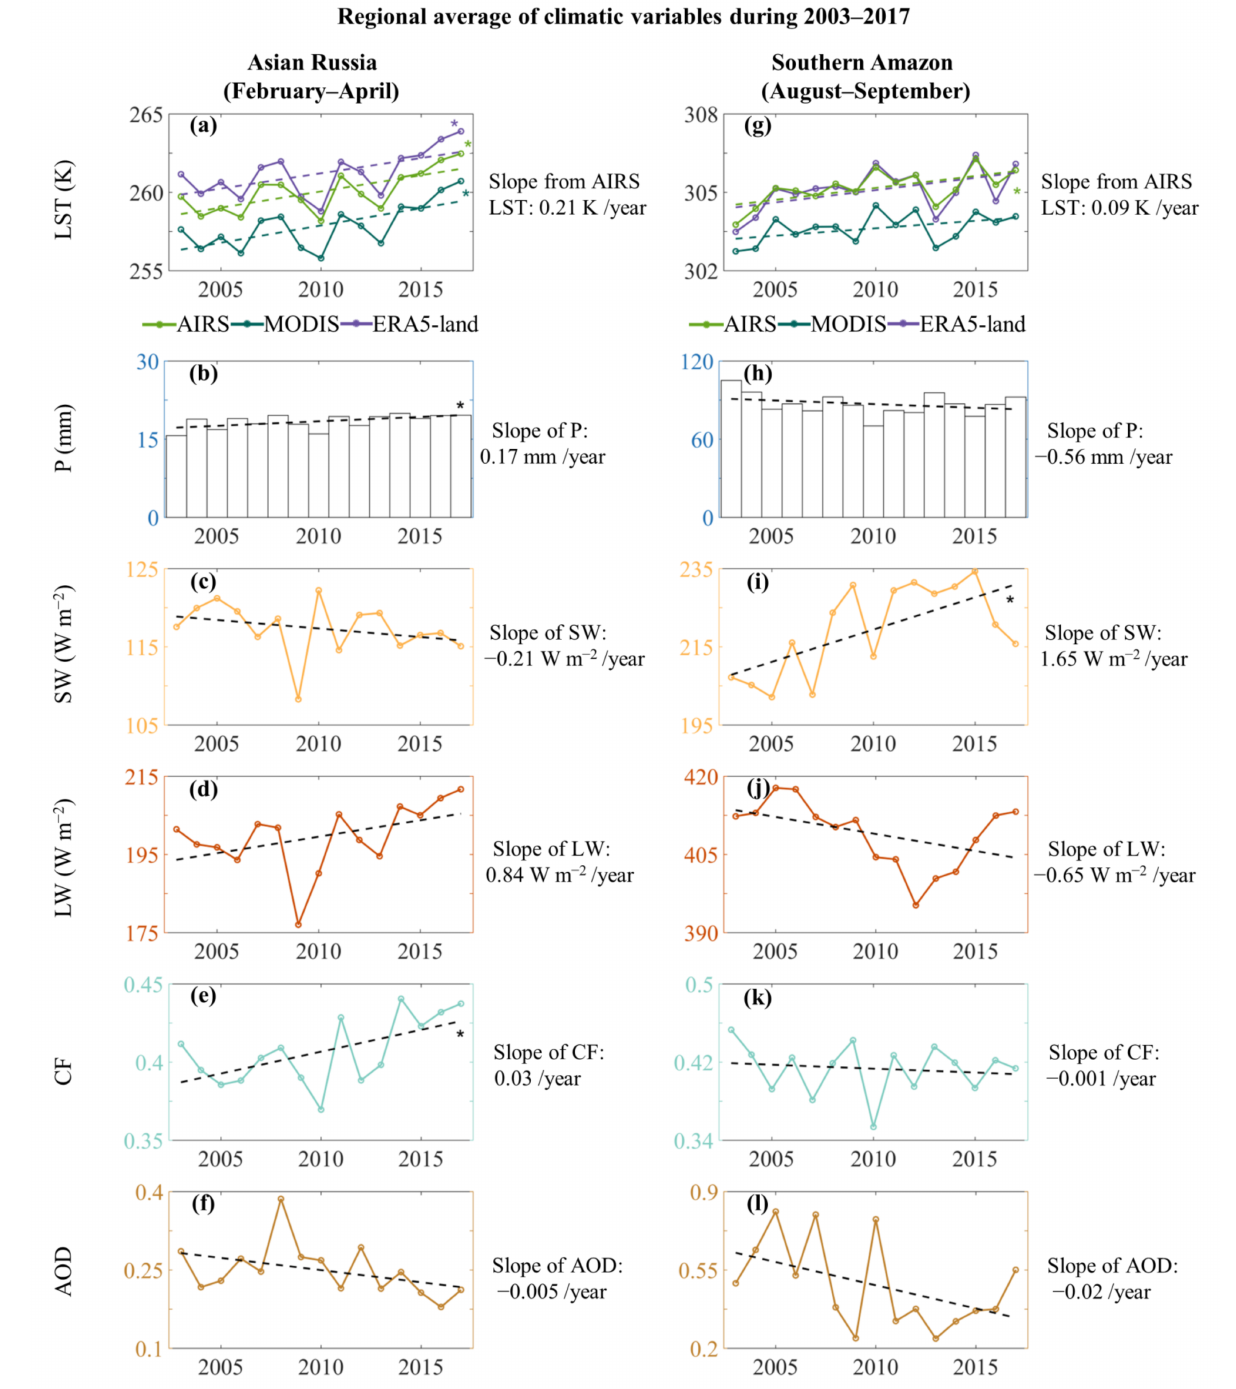
Figure 5. ( a – c ) (Left column) The regional average ( a ) LST from AIRS, MODIS, and ERA5-Land and ( b ) the precipitation (P); ( c ) incoming surface solar radiation (SW ↓ ); ( d ) incoming surface longwave radiation (LW ↓ ); ( e ) cloud fraction (CF); and ( f ) aerosol optical depth (AOD) over Asian Russia during February–April for each year from 2003 through 2017. Dashed lines indicate the linear trends, while the asterisks represent statistically significant ( p < 0.05) trends. (Right column) Same as the left column, but over the southern Amazon during August–September for 2003–2017. The rates of change (slope) for all the variables are also shown in the